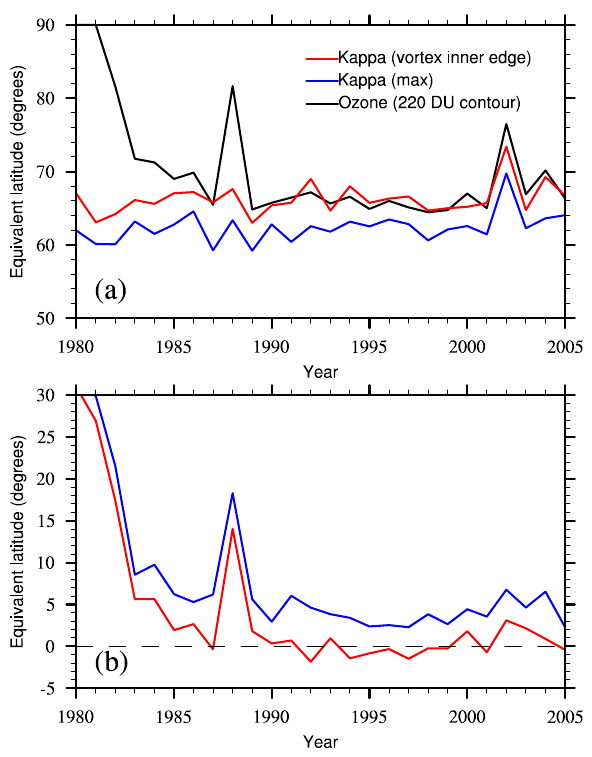
Fig. 2. (a) October mean equivalent latitude of the 220 DU contour (black line), the center of the vortex edge (blue line) and the inner vortex edge (red line). (b) Difference between the equivalent latitude of the 220 DU contour and the center of the vortex edge (blue line), and the inner vortex edge (red line). The ozone results are derived from the NIWA combined data-base and the vortex edge time series are from the NCEP/NCAR reanalyses. See text for definitions of the center of the vortex edge and the inner vortex edge.